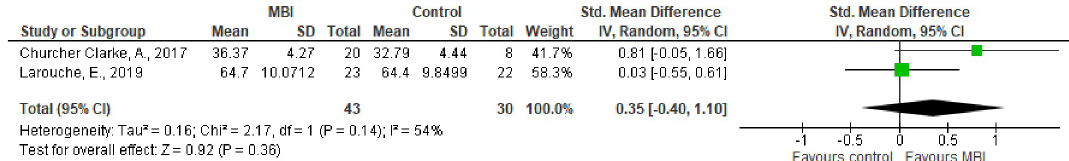
PLOS ONE | https://doi.org/10.1371/journal.pone.0255128 August 2,